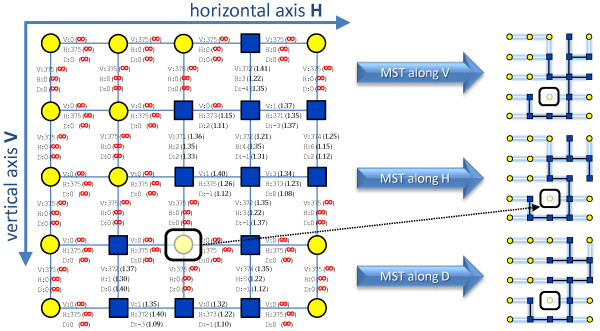
Optimal tiles placement using a minimum spanning tree (MST). Weighted undirected graph of tiles whose edges represent displacements. Weights are computed as the inverse of displacements reliability measures, yielding + ∞for the unreliable ones. These prevents the tree connecting stitchable tiles (marked as blue squares) from passing through the nontistchable ones (marked as yellow circles). If different reliability measures are available along the three directions, as in the case of using MIP-NCC to compute misalignments, three minimum spanning trees are obtained for each direction separately. The marked tile in the figure is a nonstitchable tile which is excluded from any MST path traversing stitchable tiles.